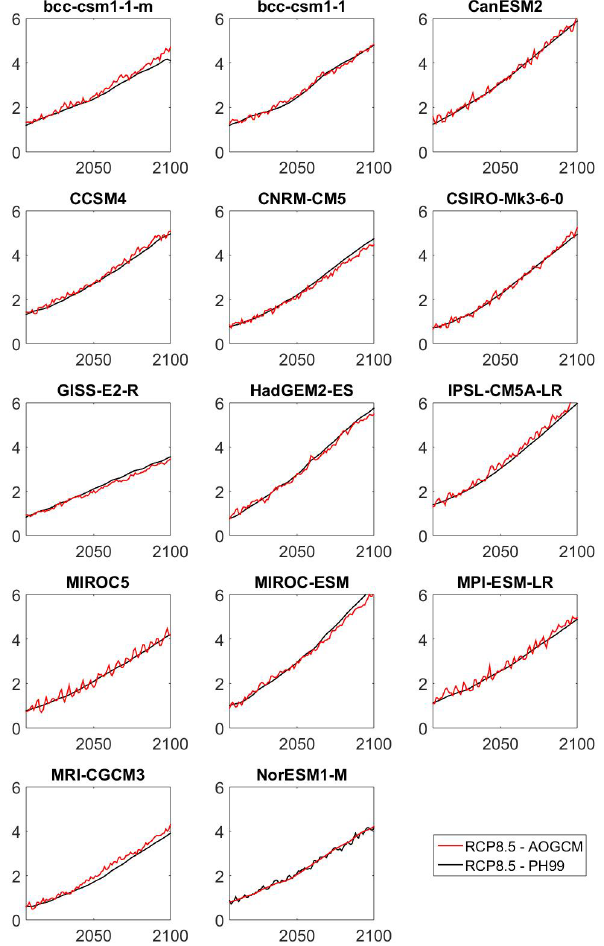
Figure 4. Comparison of temperature evolutions (K) projected by the climate module PH99 (black solid curves) in the RCP8.5 sce- nario to the actual AOGCM’s temperature (red solid curves) in the RCP8.5 scenario. α and µ are taken from the second step, in which PH99 is calibrated to the RCP2.6 scenario.